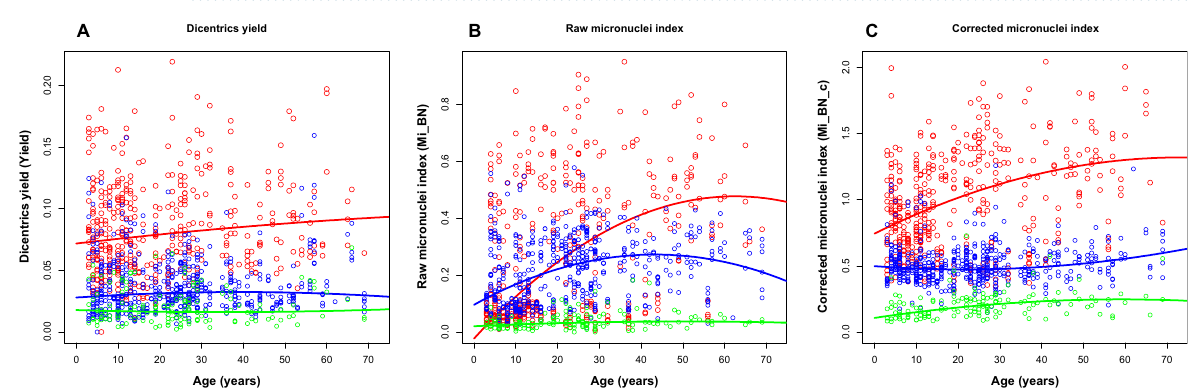
Figure 2. Dose responses for the yields of dicentric chromosomes (per total number of chromosomes in the sample, ( A ), and raw micronuclei ( B ) and corrected (linearized) micronuclei ( C ) per cell. Circles represent the data for individual blood samples, and curves represent linear-quadratic quantile regression fits that describe the median (50th percentile) of the distribution of each variable. The data (circles) were randomly “jittered” by small amounts along the x-axis to improve visualization by reducing overlap. The dose values were 0, 3, 4, and 8 Gy.